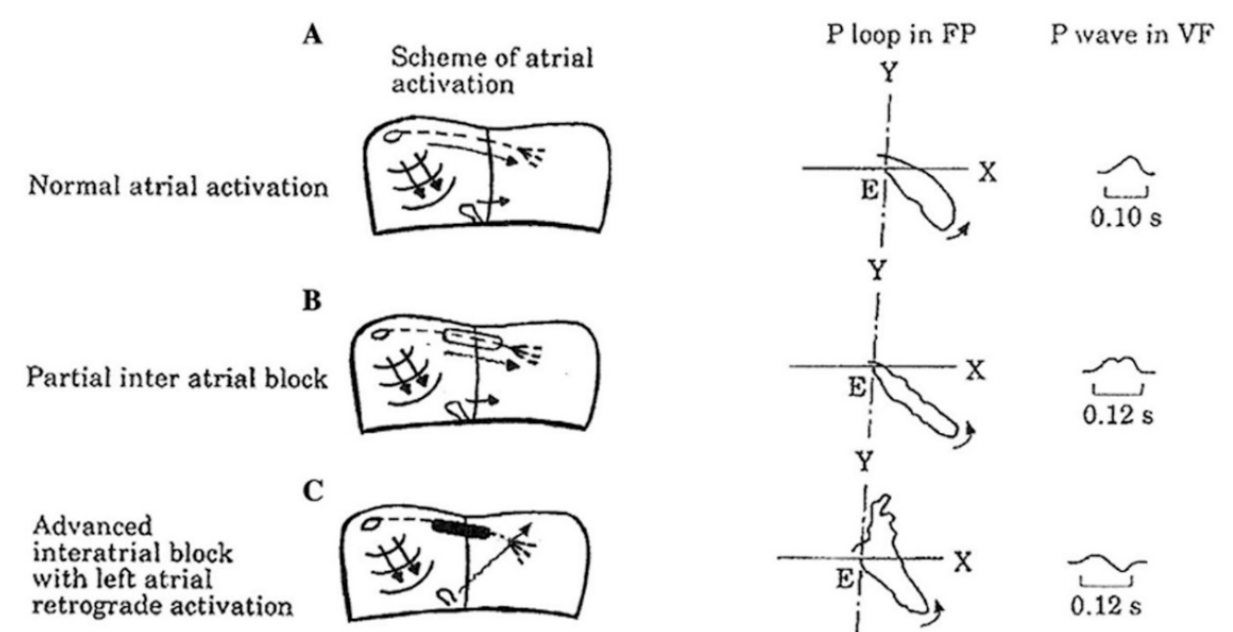
Figure 1. ( A ) Diagram of atrial conduction under normal circumstances; ( B ) partial interatrial block, and ( C ) typical advanced interatrial block with left atrial retrograde activation (IAB with LARA) .